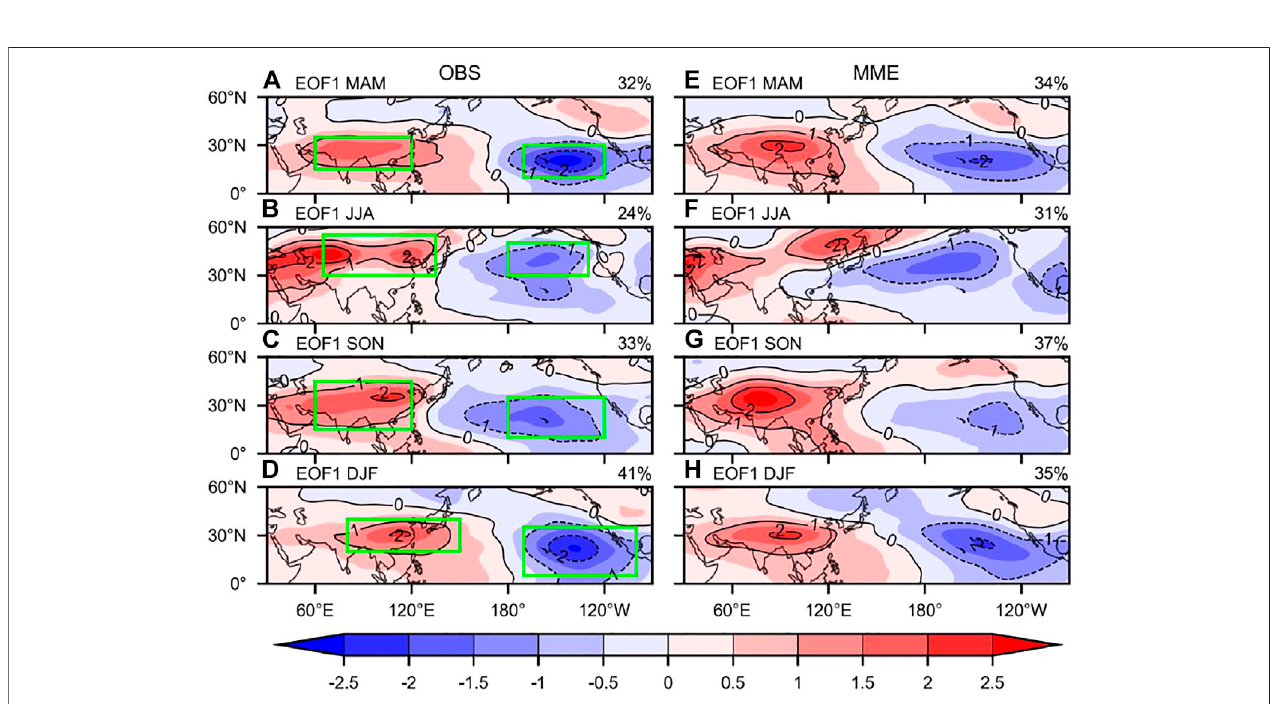
FIGURE 3 | EOF1 (×0.01) mode of (A,E) spring, (B,F) summer, (C,G) autumn and (D,H) winter UTT during 1965 – 2014 from (A – D) NCEP/NCAR reanalysis and (E – H) MME simulation. Green boxes in (A – D) are used to de fi ne APO index.